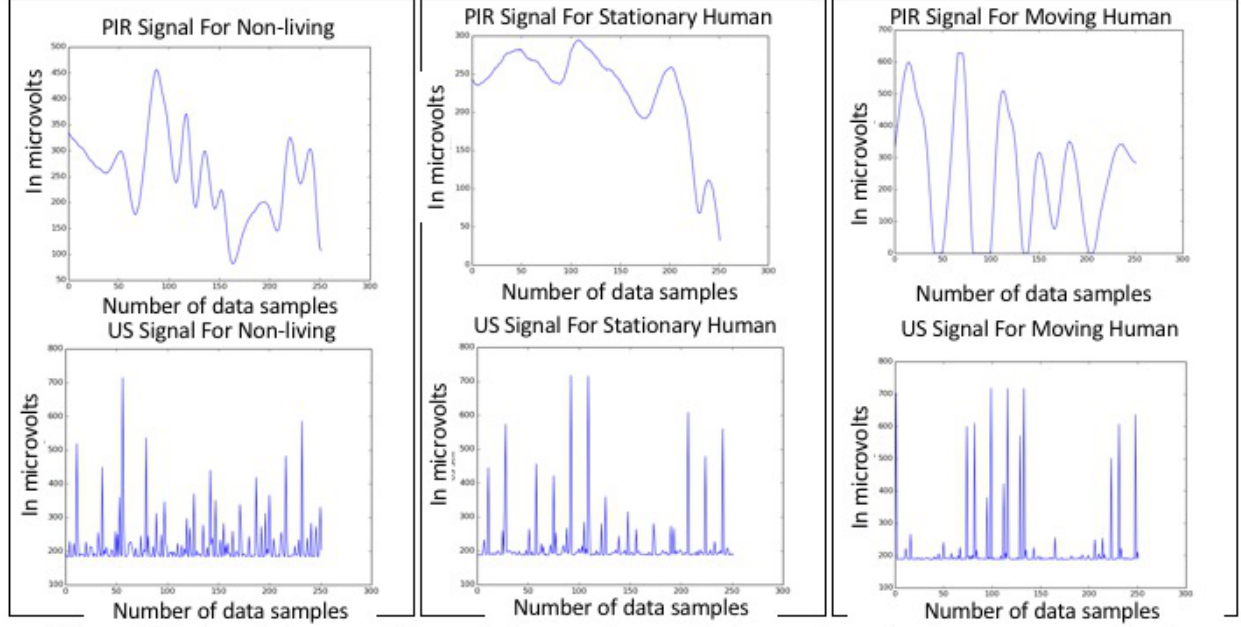
Figure 3. Input to the system under various conditions